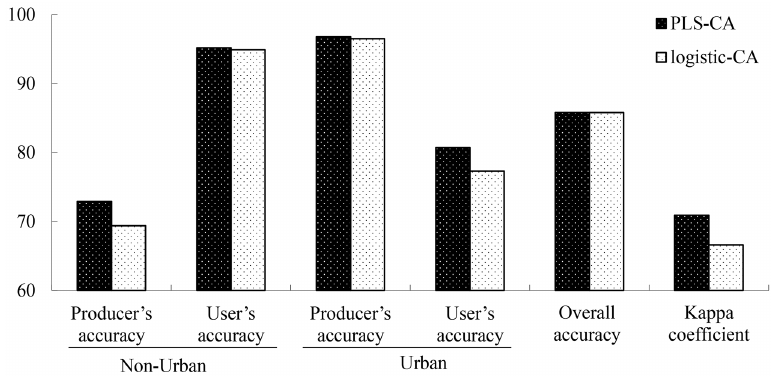
Figure 6. Simulation accuracy (%) of the two CA models in 2008.